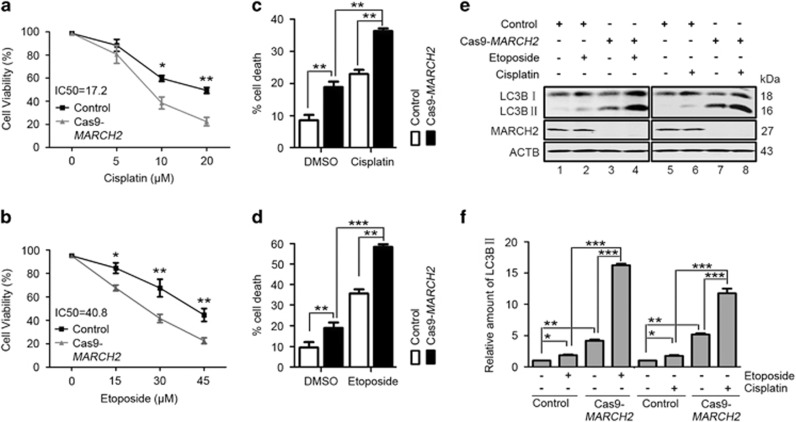
Knockout of MARCH2 sensitizes HCT116 cells to chemotherapy. (a, b) Control cells and Cas9-MARCH2 cells were cultured in 96-well plates (5000 cells/well, five replicate wells), treated with indicated dose of cisplatin or etoposide for 24 h. Cell viability was assessed using the MTS assay. The IC50 of etoposide or cisplatin is 17.2 μM or 40.8 μM, respectively. Data are mean±S.D. of three independent experiments. (c, d) Control cells and Cas9-MARCH2 HCT116 cells were treated with or without etoposide or cisplatin for 24 h. Apoptosis was quantified by Annexin-V/PI staining and flow cytometry. (e) Western blot of the levels of LC3B-II in cells treated as described in (c). (f) Histogram of the of LC3B-II/ACTB ratio for cells treated as described in e. The average value in the control group was normalized to 1. Data are mean±S.D. of three independent experiments. *P<0.05, **P<0.01, ***P<0.001